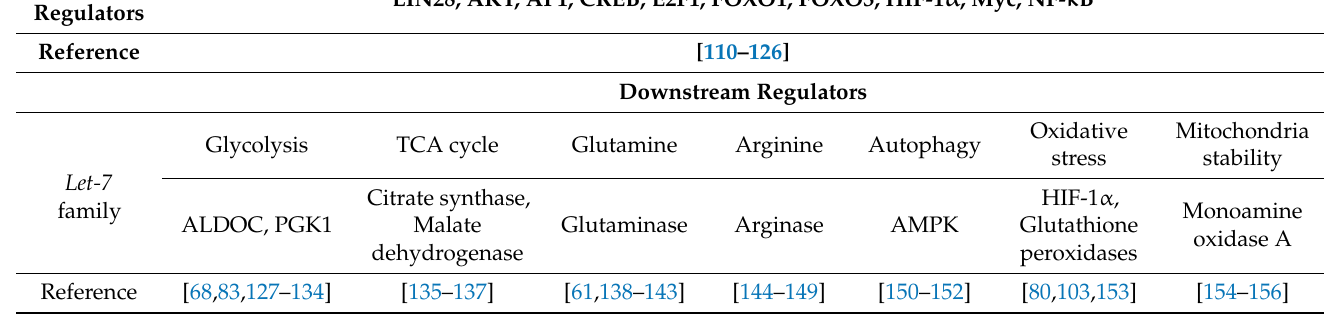
Table 3. Simulated results profiling of Let-7 regulators, linked to autophagy and glucose metabolism. All molecules related to the Let-7 family were downloaded from the ENCORI database (https: //starbase.sysu.edu.cn/index.php, accessed on 20 September 2021) and processed using Ingenuity Pathway Analysis (https://analysis.ingenuity.com, accessed on 20 September 2021) to link to the possible molecular